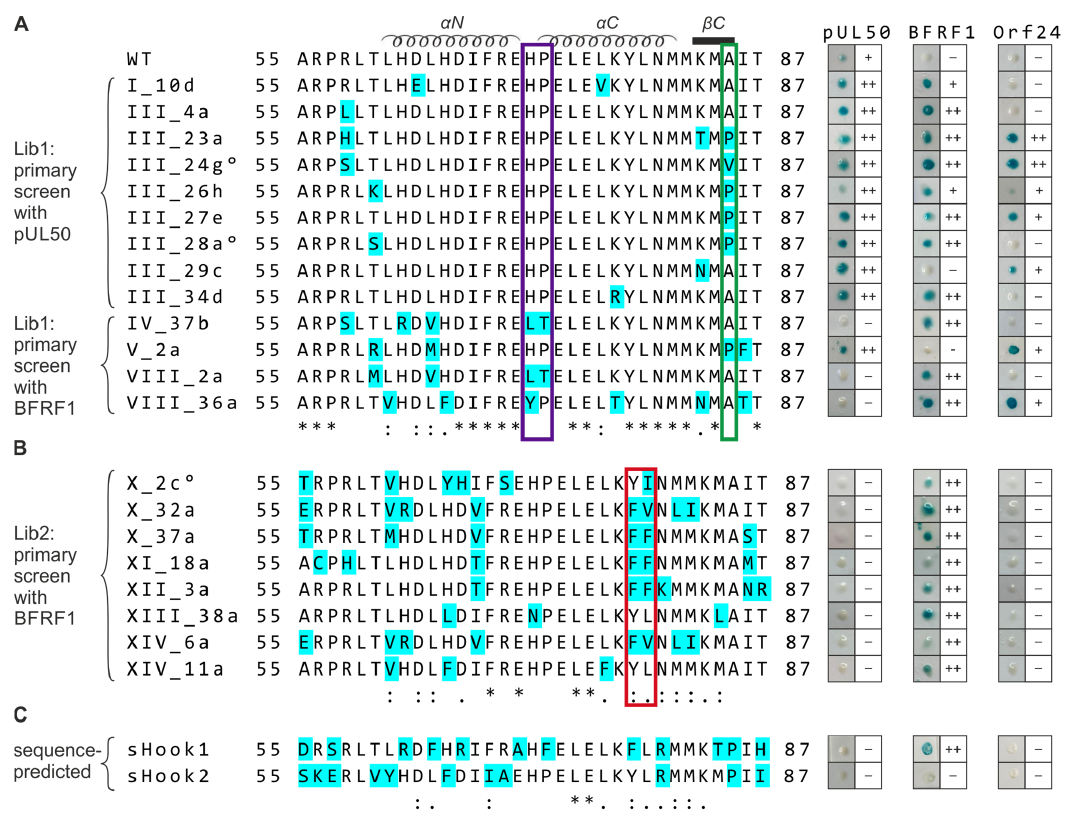
Figure 6. Sequence alignment and Y2H data comparing the hook region of WT pUL53, library ‐ selected and sequence ‐ predicted clones referring to their shared ‐ hook binding properties with three different groove proteins. Amino acid sequences of the ( A , B ) WT pUL53 hook region (amino acids 55–87), the library clones listed below and ( C ) the sequence ‐ predicted shared ‐ hook constructs were aligned using the online multiple sequence alignment tool ClustalW2. Mutated residues are highlighted in cyan. °, indicates further amino acid exchanges were detected upstream the hook region (i.e., A43T for III_24g, R18S for III_28a and R8C for X_2c); *, positions of fully conserved residues; :, positions conserved within groups of strongly similar properties (i.e., scoring > 0.5 in the Gonnet PAM 250 matrix); ., positions conserved within groups of weakly similar properties (i.e., scoring ≤ 0.5 and >0 in the Gonnet PAM 250 matrix). In the Y2H analysis, pUL53 library clones were identified by primary screening against HCMV pUL50 ( A , upper part) or EBV BFRF1 ( A , lower part, B ). All primary positive clones, including sequence ‐ predicted constructs ( C , sHook1 and sHook2), were then used for a backtransformation ‐ based confirmation step and shared ‐ hook analysis against HCMV pUL50, EBV BFRF1, or VZV Orf24, respectively, as shown at the right. The positivity rate of blue yeast colonies detected in the Xgal filter lift assay is indicated: ++, ≥ 50%; +, <50%; –, not detectable.